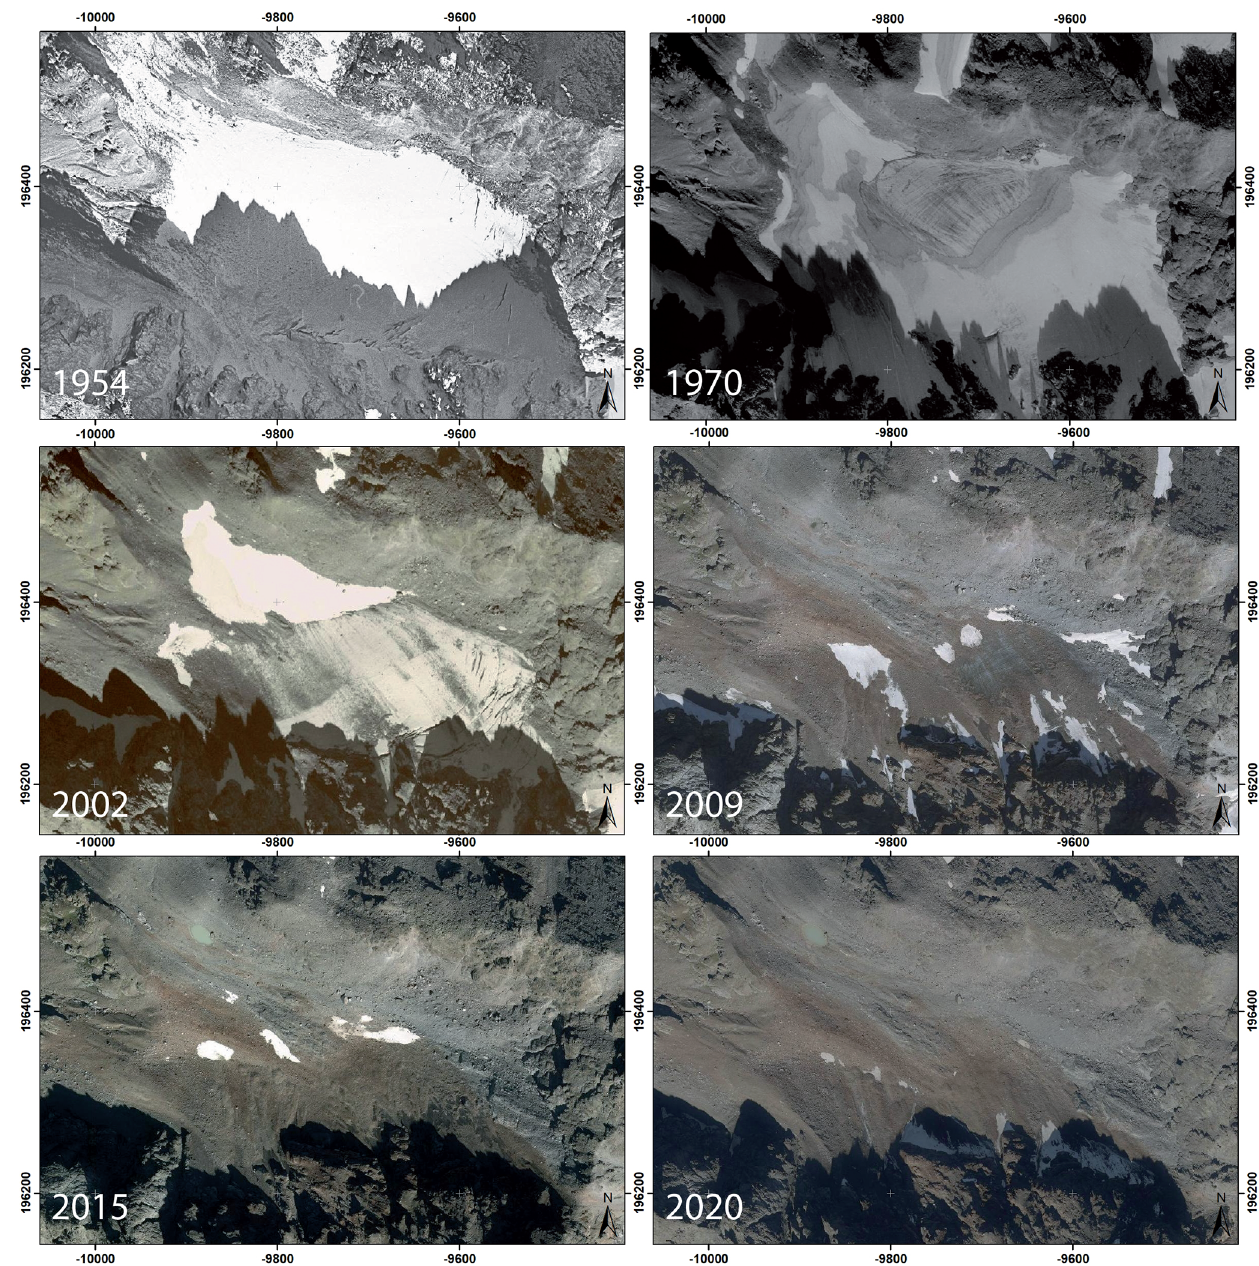
Figure 5. The evolution of Schnapfenkuchl glacier V in a time series of orthophotos from 1954 to 2020 illustrates that the evolution from a glacier with crevasses as visible indicators of ice dynamics took just 20 years. In the orthophotos of 2009 and 2015, bare ice is still visible at the surface. Orthophotos: CC 4.0 https://www.data.gv.at/katalog/en/dataset/orthofoto.